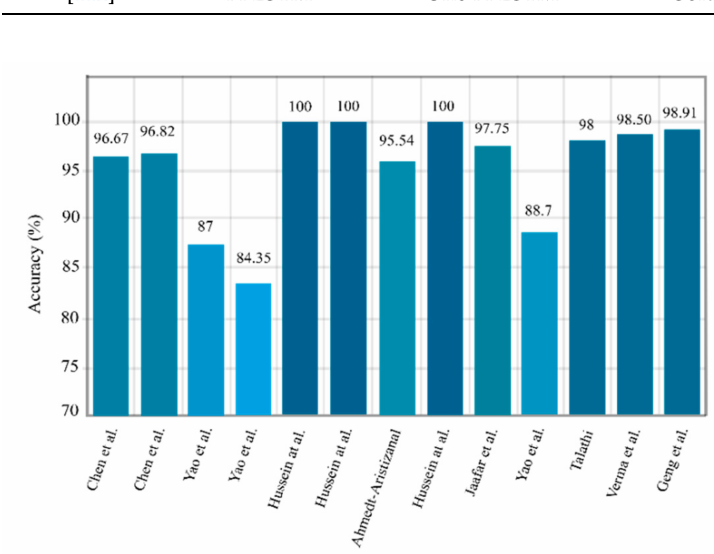
Figure 11. Sketch of accuracy (%) obtained by authors using RNN models for seizure